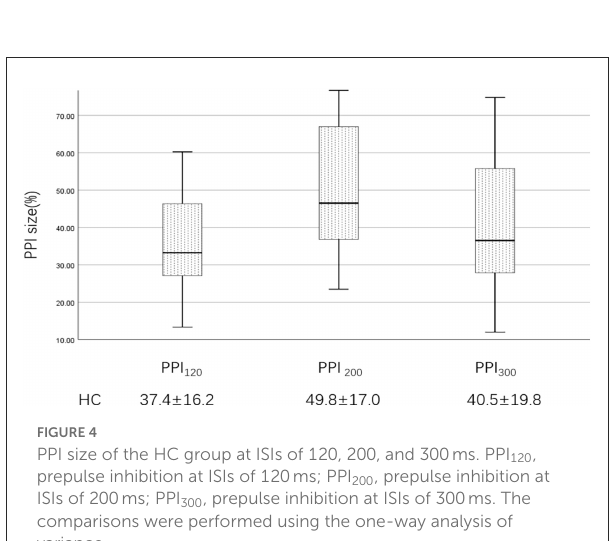
FIGURE4 PPI size of the HC group at ISIs of 120, 200, and 300ms. PPI 120 , prepulse inhibition at ISIs of 120ms; PPI 200 , prepulse inhibition at ISIs of 200ms; PPI 300 , prepulse inhibition at ISIs of 300ms. The comparisons were performed using the one-way analysis of